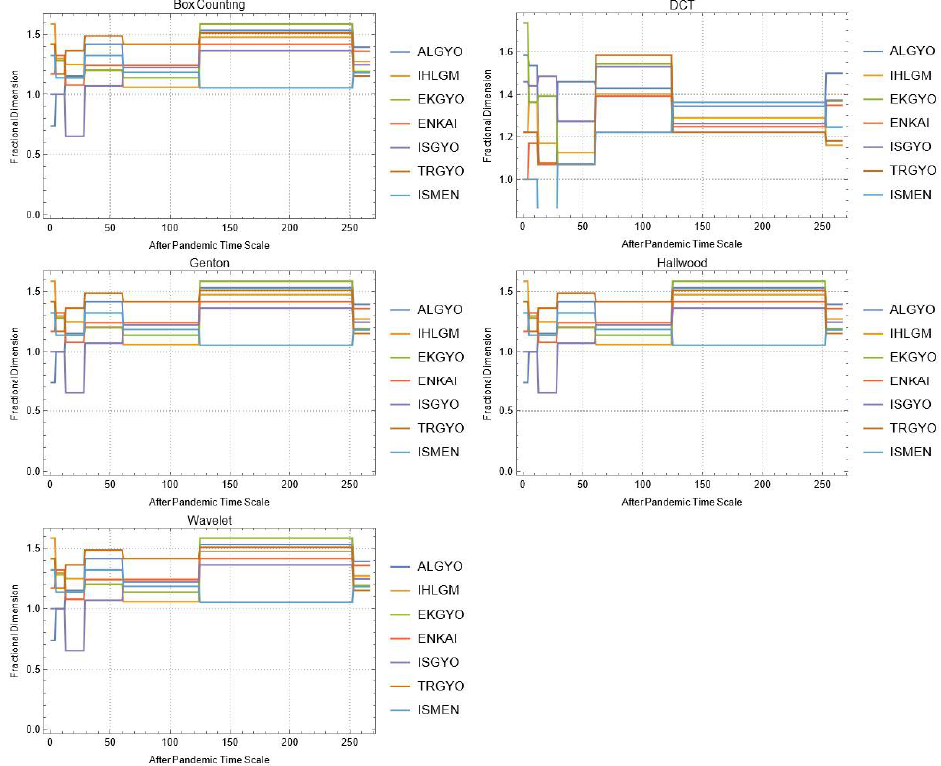
Figure A16. Daily changes of fractal dimensions after the pandemic (energy).